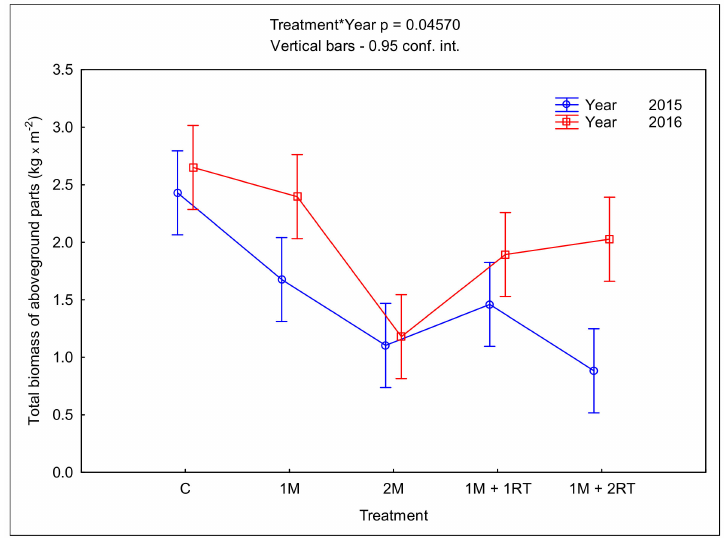
Figure 7. Mean fresh mass of the aboveground parts of plants per 1 m 2 , depending on the type of mechanical treatment. The following symbols denote the research treatments: C: control; 1M: one-time mowing; 2M: two-time mowing; 1M + 1RT: one-time mowing with one-time rotary tilling; 1M + 2RT: one-time mowing with two-time rotary tilling.